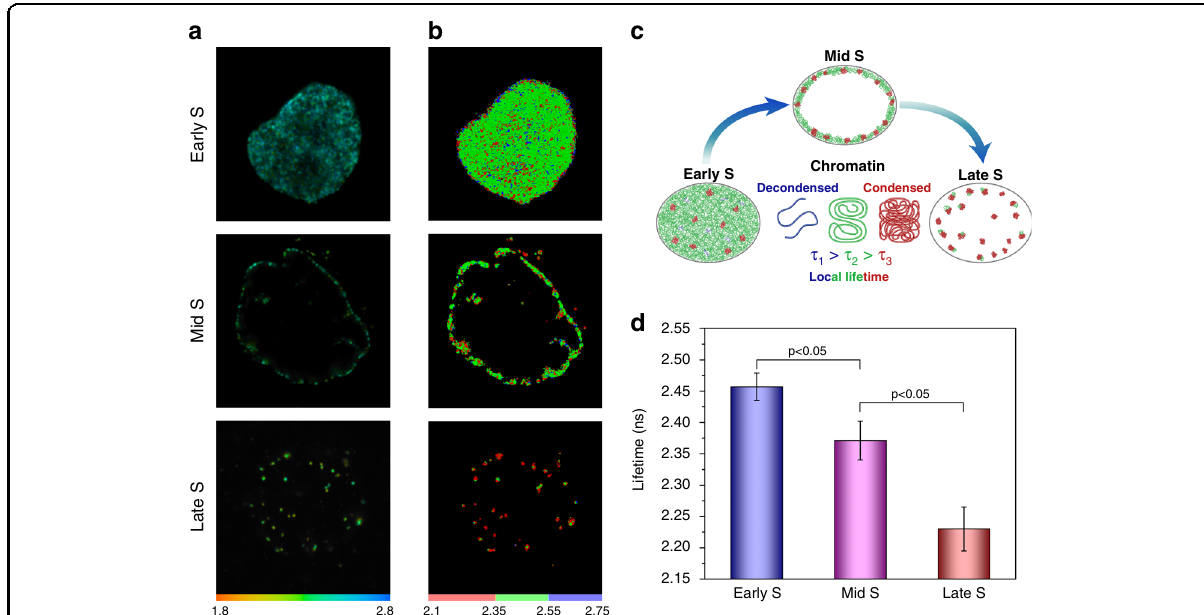
Fig. 1 Dependence of fl uorophore ’ s lifetime on chromatin replication timing. a Representative fl uorescence lifetime images of early, mid, and late S-phase DNA replication sites labeled with AlexaFluor 546. Corresponding lifetime histograms are demonstrated in Fig. S3. b Color-coded image of the lifetime distribution throughout cell nucleus. c Schematics of the FLIM approach to measure compaction of chromatin replicating at different S-phase windows. d Averaged fl uorescence lifetime of AlexaFluor 546 used to label DNA replication sites in early, mid, and late S-phase. The error bars correspond to standard deviations. See Fig. S4 for additional